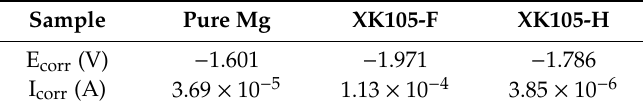
Table 1. Electrochemical properties of XK105 and pure Mg.